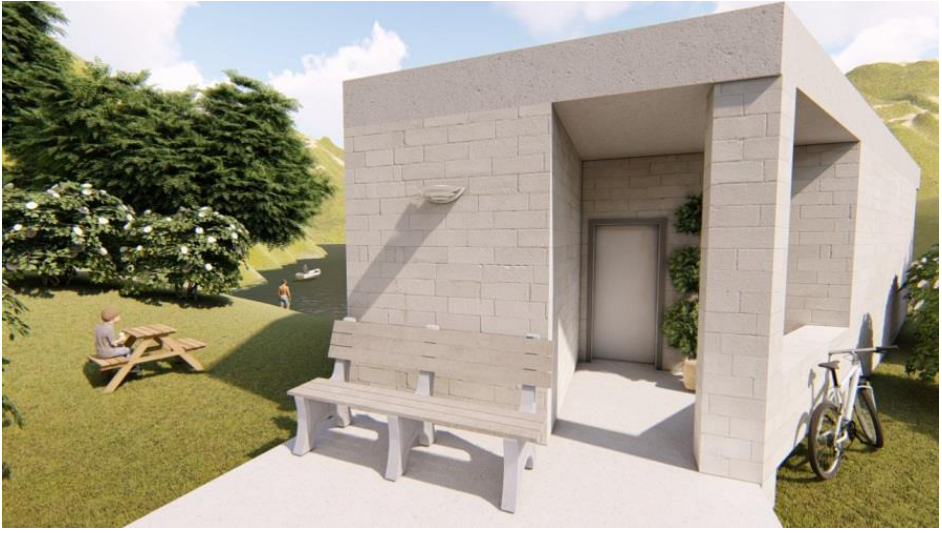
Figure 43. Entrance to the tourist residential unit. Every house has its own privacy overlooking the Danube. Lepenski Vir, Serbia (2019) by ArhiArhi (Predrag, Vladimir and Grigor Milošević)